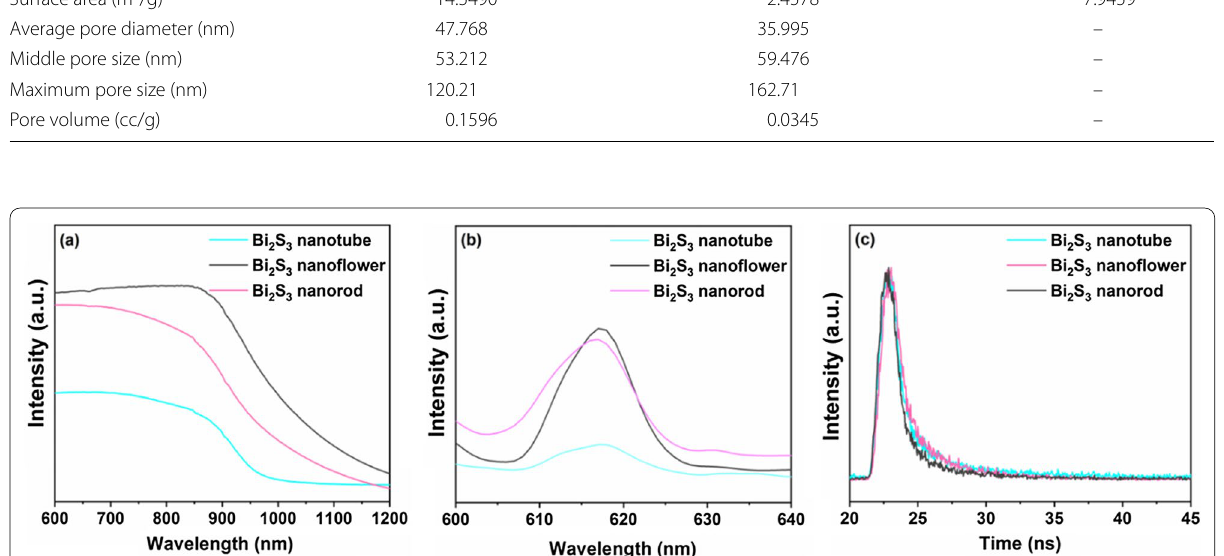
Fig. 5 a UV–vis DRS spectra, b photoluminescence spectra and c time-resolved fluorescence emission spectra of the Bi 2 S 3 samples with different morphologies